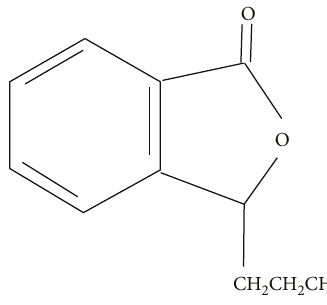
Figure 1: Chemical structures of